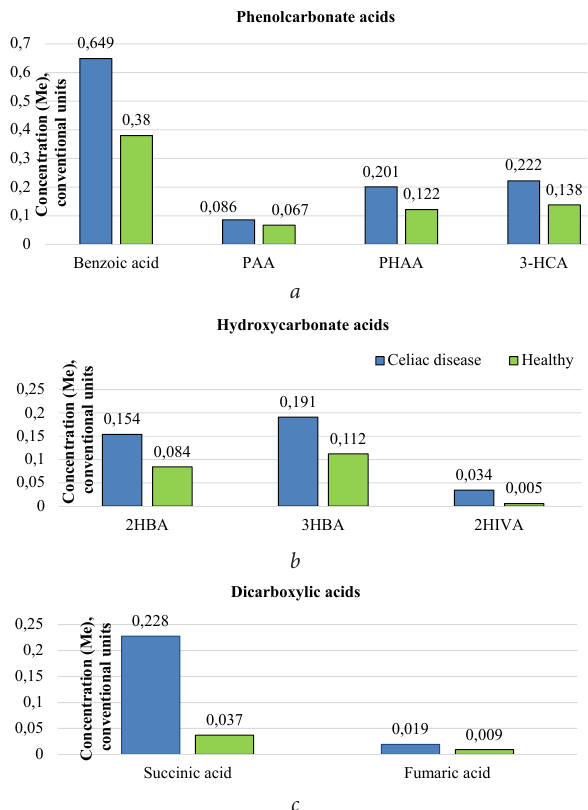
Fig. 1. The concentration of acids in the blood serum of patients with celiac disease and healthy volunteers : a – phenocarboxylic acids; b – hydroxycarboxylic acids; c – dicarboxylic acids; PAA – phenylacetic acid; PHAA – parahydroxyphenyl acetic acid, 3-HCA – hydroxycinnamic acid, 2HBA – 2-hydroxybutyric acid, 3HBA – 3-hydroxybutyric acid, 2HIVA-2-hydroxyisovalerate acid Changes in the concentration of monocarboxylic acids did not have statistical significance compared with healthy volunteers. A decrease in the level of eicosadiene and an in- crease in arachidonic acids in blood included in the group of polyunsaturated fatty acids (ω-6-PUFA) were determined. In addition, a number of metabolic indices, biomarkers of fatty acid metabolism, were calculated. Thus, the level of increase in arachidonic acid (AA) in the blood of patients with celiac dis- ease did not have significant differences with the control group ( Fig. 2 ). However, the ratio of AA to eicosadienoic acid (EDA) (C20: 4n-6/C20:2n-6) was statistically significant (4.84 vs. 3.28, p=0.033; Mann-Whitney U-test). The elongase activity index in patients with celiac disease tended to increase, but the differences were not statistically significant (p=0.067; Mann- Whitney